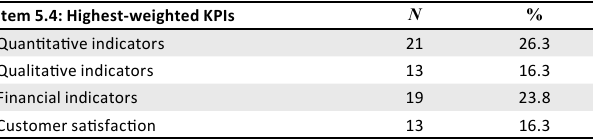
TABLE 9: The first performance measure call centre managers look at if they have been out of the office.